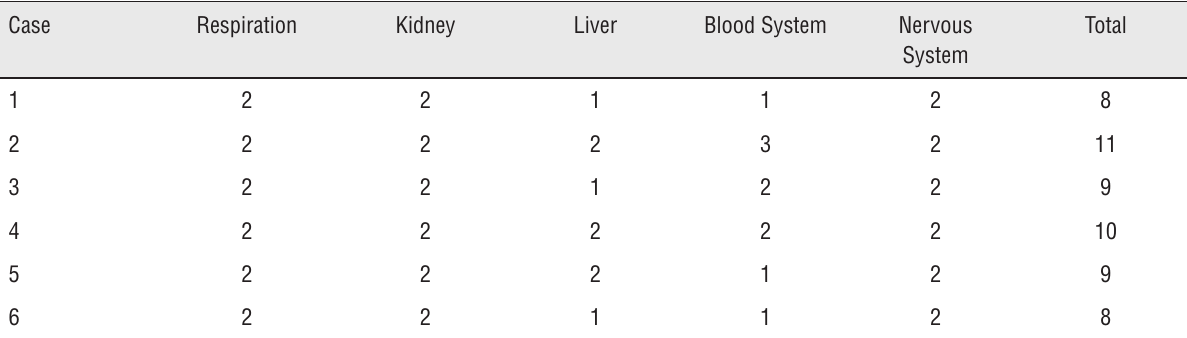
Table 3 - Summary of multiple organ dysfunction scores for each critally ill child who received continuous renal replacement